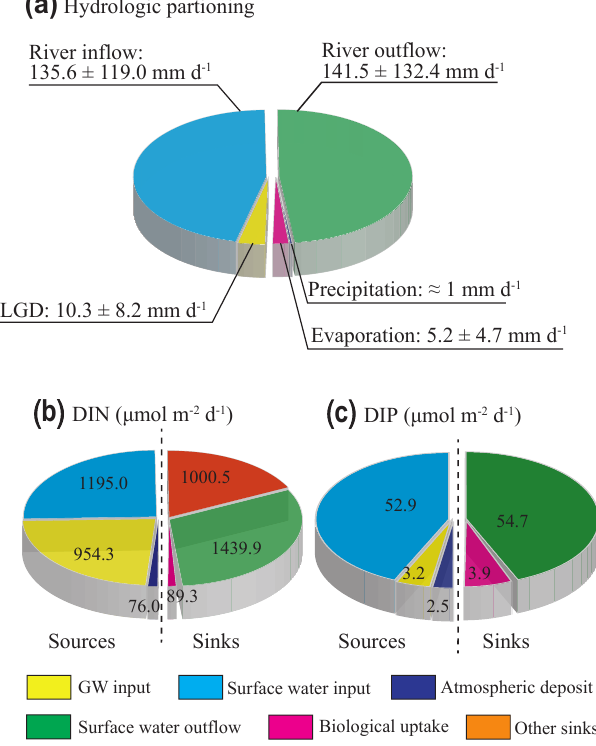
Figure 8. The hydrologic partition of the proglacial lake of Ximen Co (a) and the budgets of DIN (b) and DIP (c)